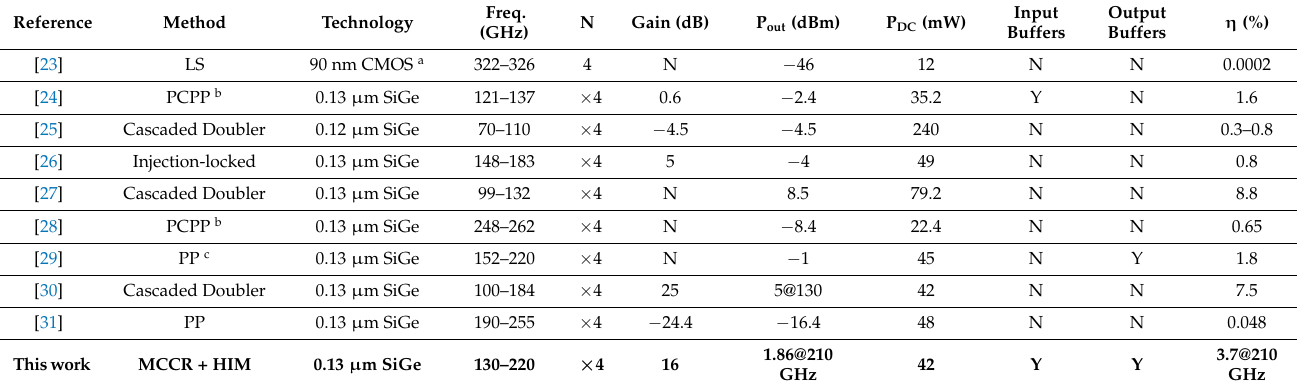
Table 2. The comparison with other